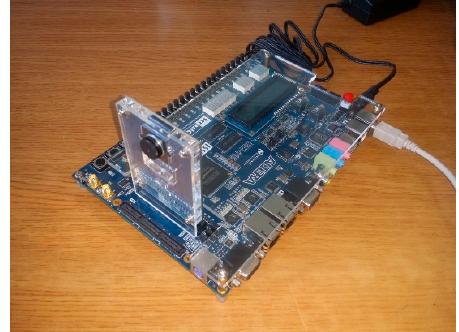
Figure 12. Experimental equipment.